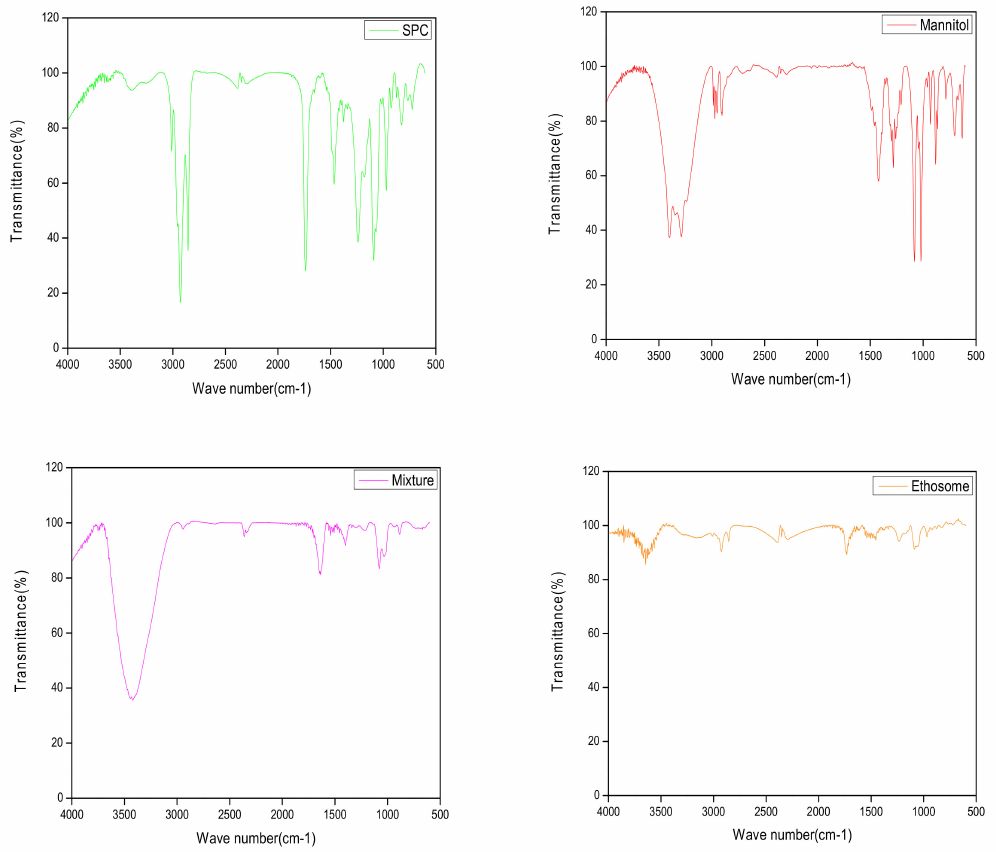
Figure 5. FT-IR spectra of paeonol, CHO, SPC, mannitol, the physical mixture and ethosome freeze-dried